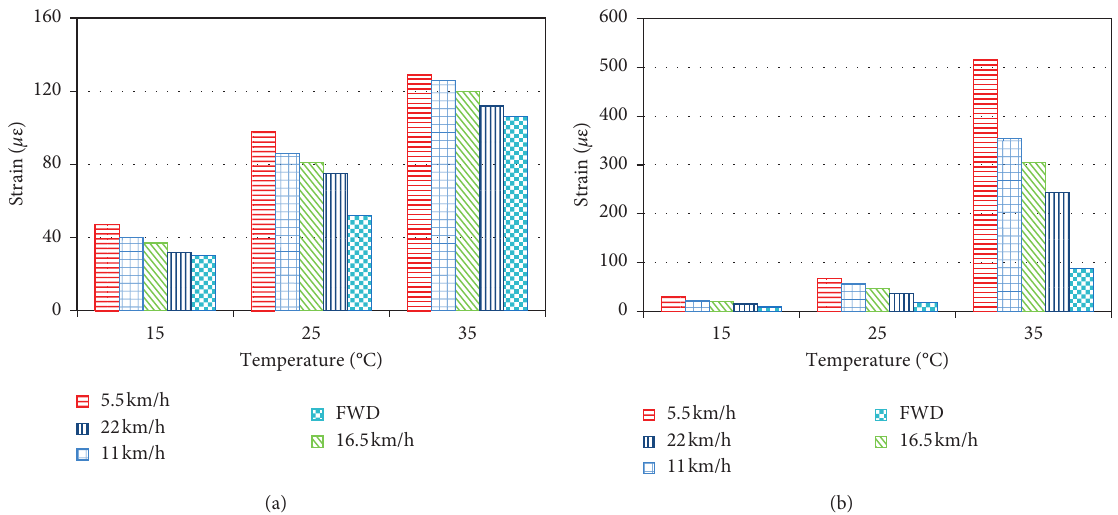
Figure 11: The comparisons of pavement strain values under vehicular loading and FWD loading for (a) flexible pavement and (b) semirigid pavement.